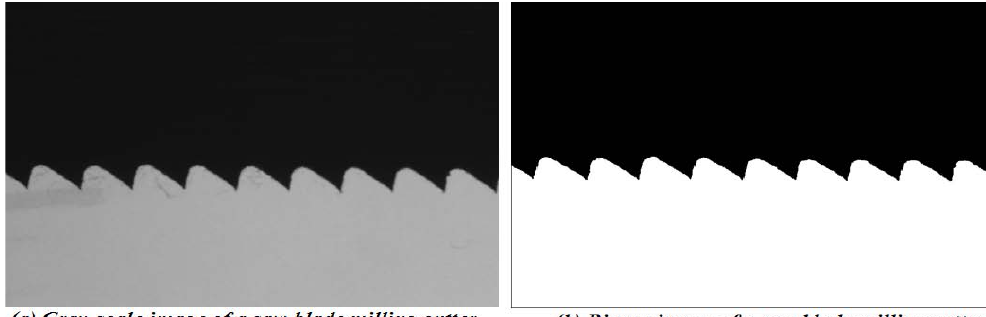
Figure 1. “Gray-scale image and binary image of a saw blade milling